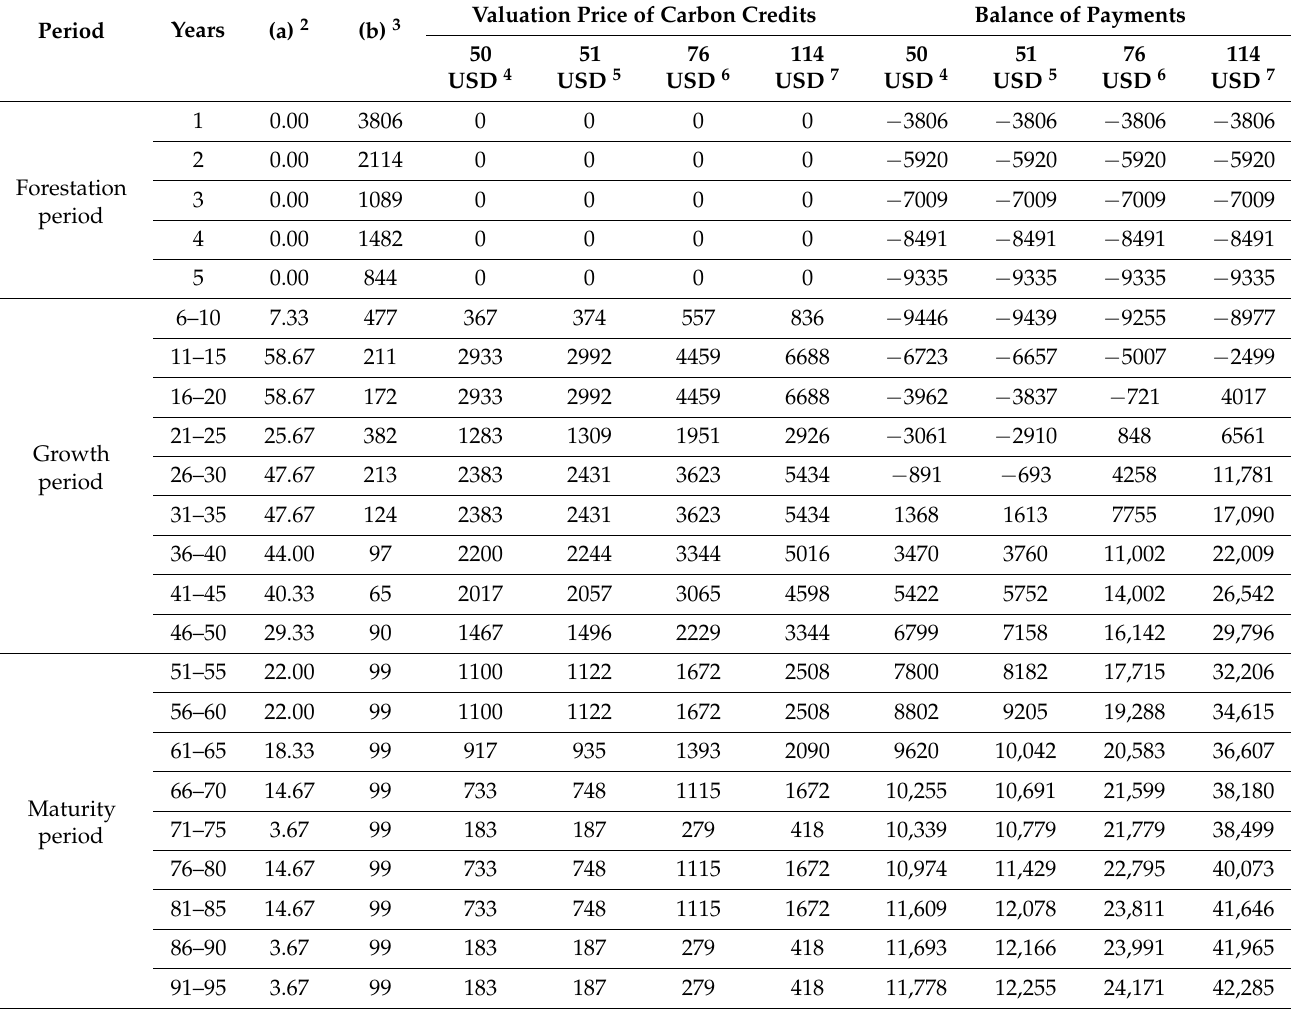
Table 6. Simulation of cedar production-forests management costs per ha and renewable credit pricing (US dollars) 1 .